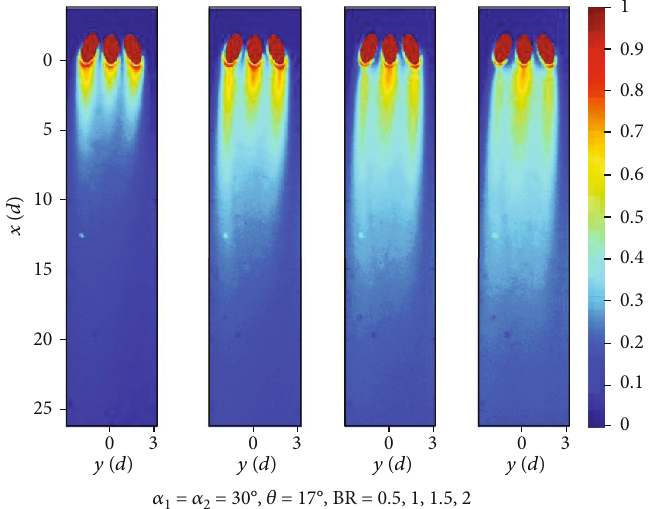
Figure 9: Film cooling e ff ectiveness distributions downstream of the branched holes, α